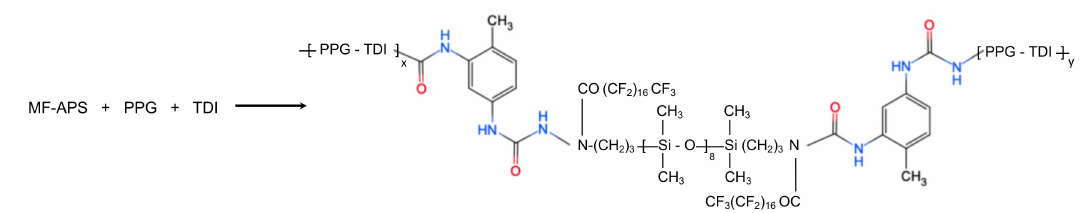
Figure 1. Synthesis of prepolymer end capped by isocyanate (–NCO)